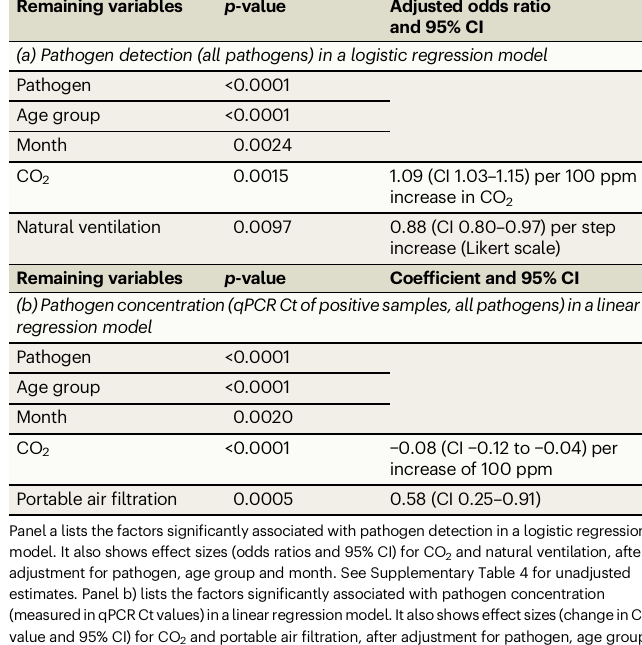
Table 1 | lists the pathogen, host, behavioural and environ- mental/building related factors signi fi cantly associated with indoor air bioaerosol load after backward elimination in (logistic)generalised linear models Remaining variables